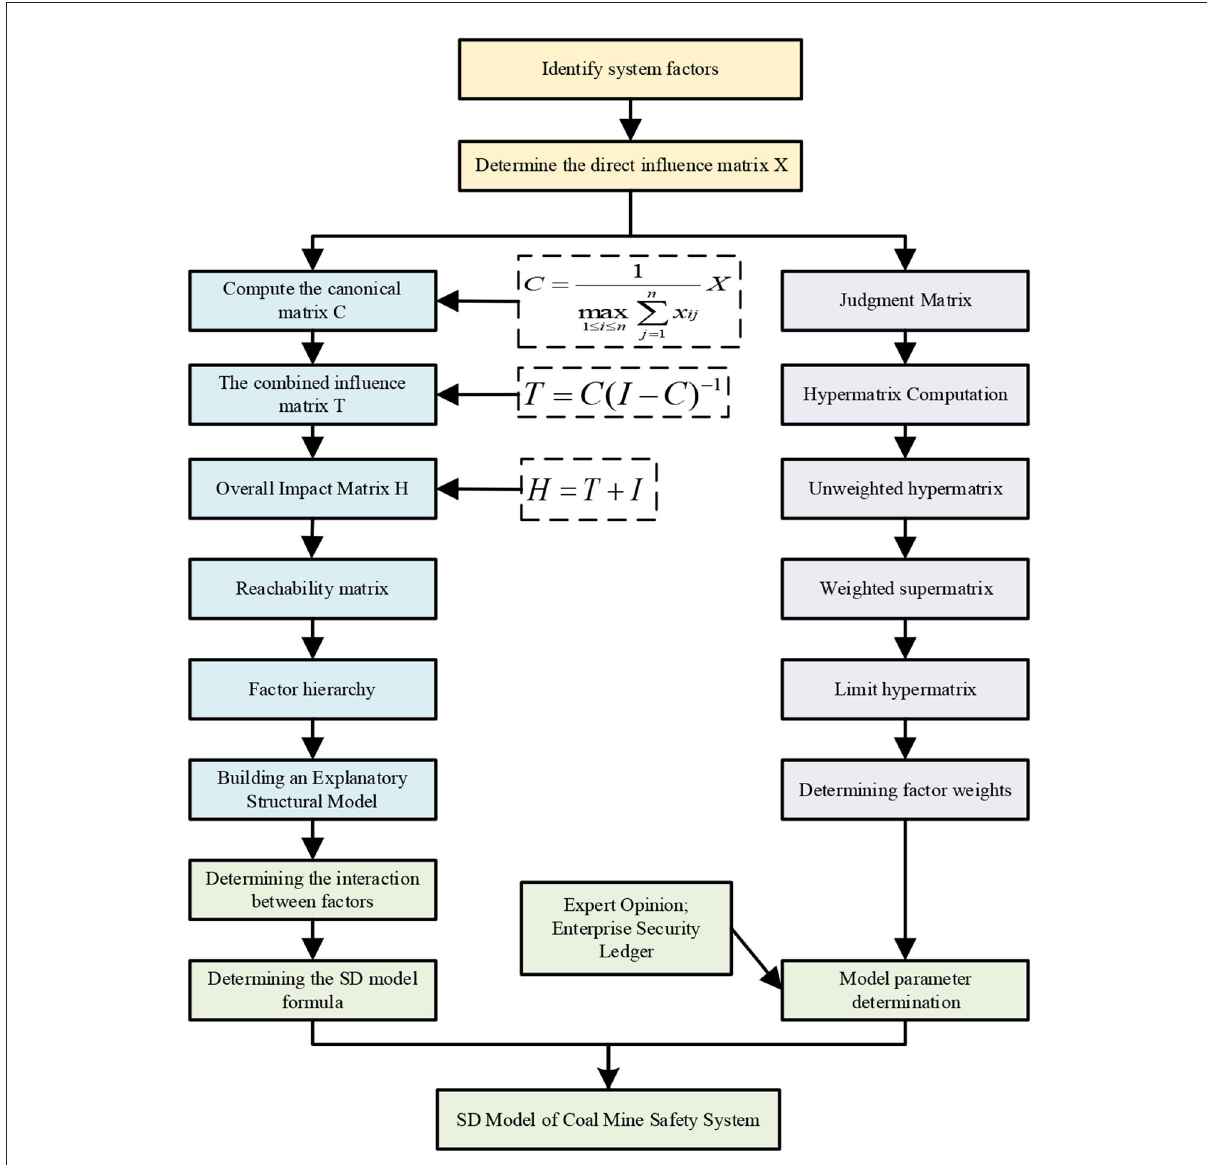
FIGURE3 Flow chart of ISM-ANP-SD model of coal mine safety system.